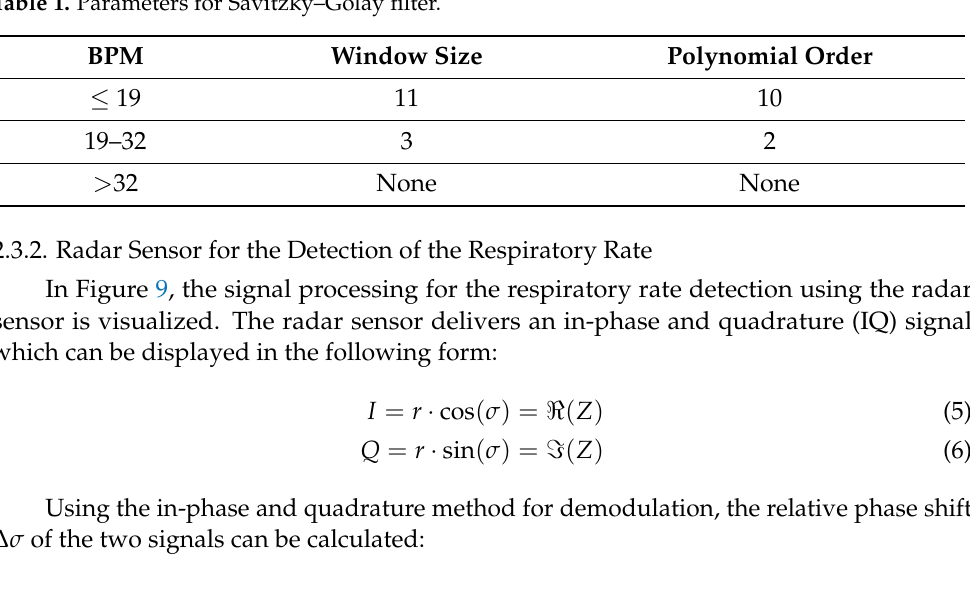
Figure 8. Unfiltered ( blue ) and filtered ( magenta ) section of the respiratory signal at 20BPM in deep mode. The Savitzky– Golay filter has a window size 3 and polynomial order 2. Table 1. Parameters for Savitzky–Golay